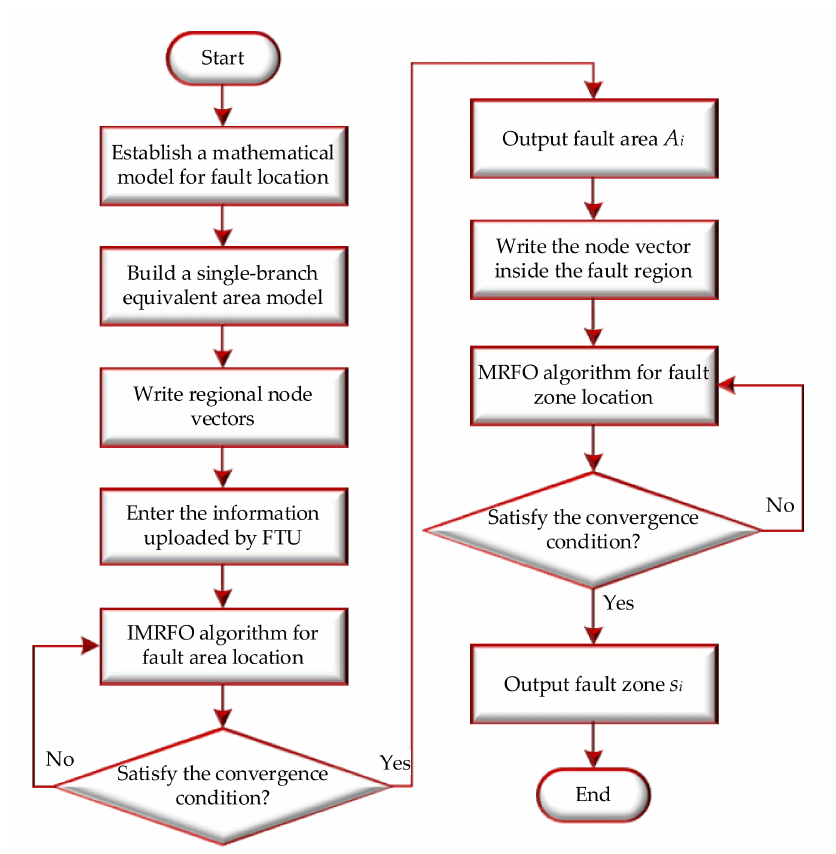
Figure 4. Distribution network regionalized fault location